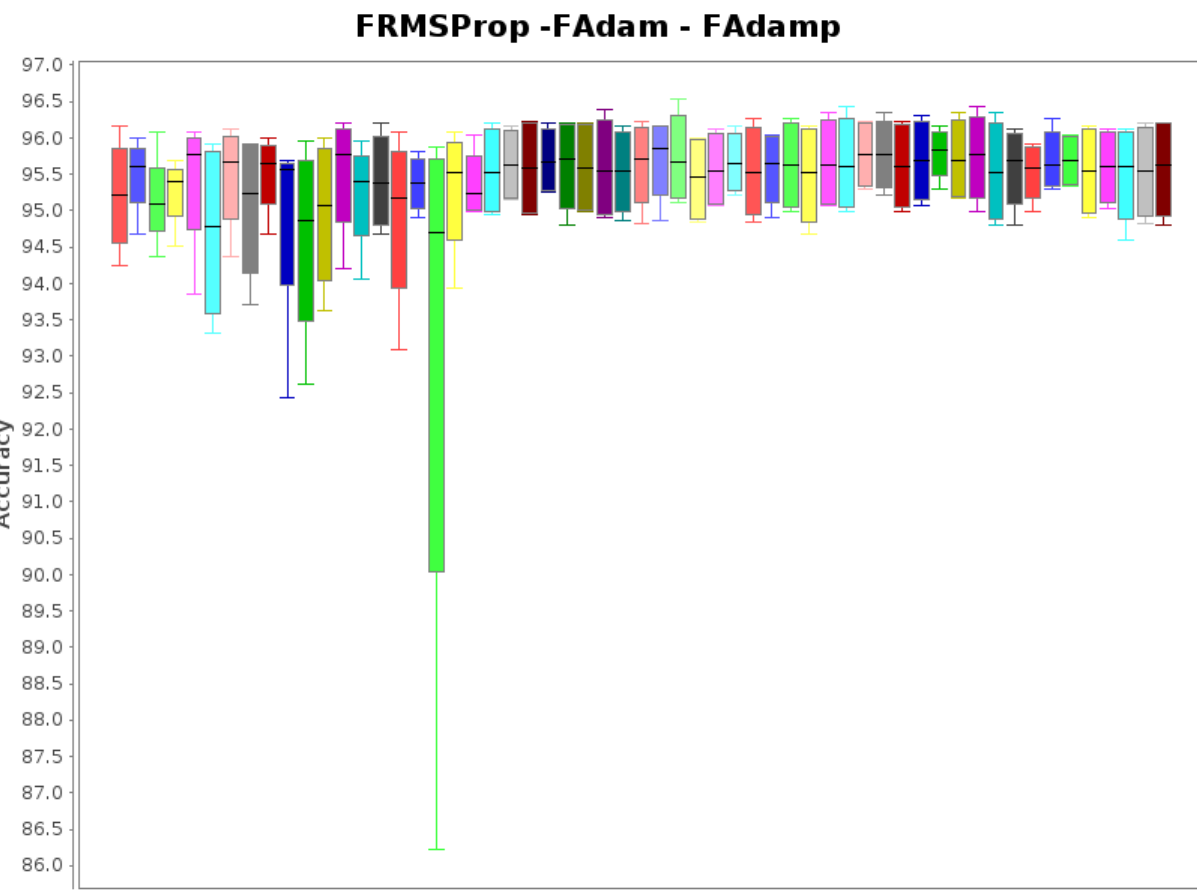
Figure 18. Experiment 3.2: Group 1, cross-folding accuracies, K = 4 folds, ν ∈ [ 0.1,1.9 ] .